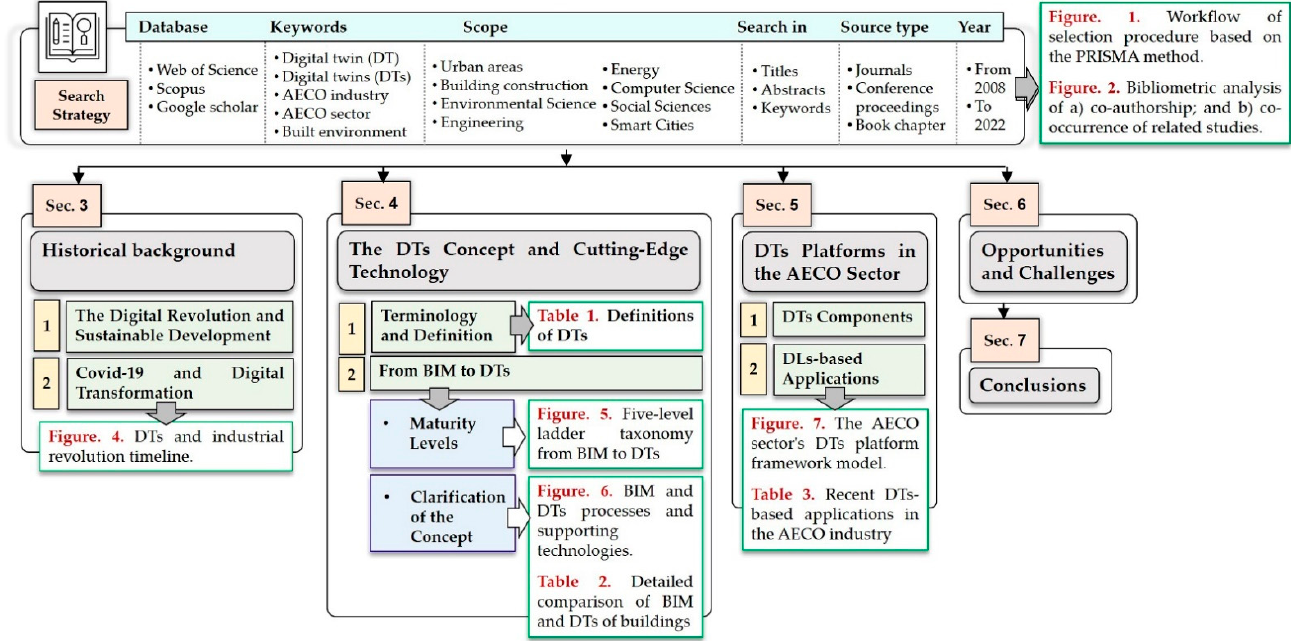
Figure 3. A graphical representation of the methodological framework.